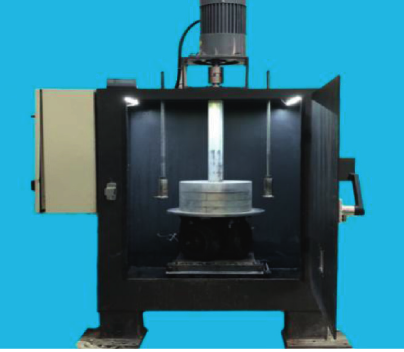
Figure 3: The accelerated wear